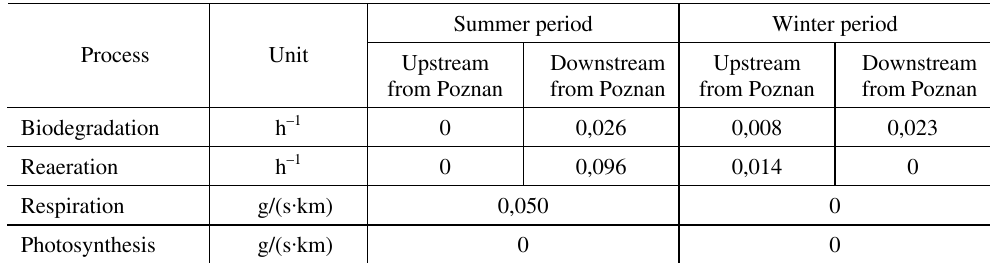
Table 5. Reaction rates of self-purification processes in the Warta River middle stretch estimated by program WODA Summer